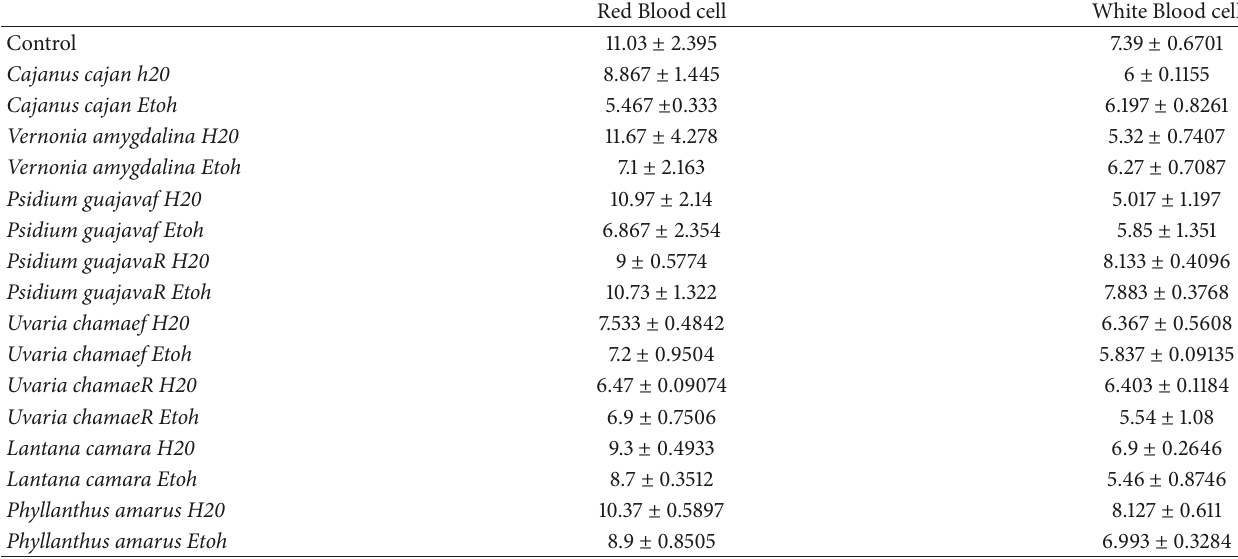
Table 3: Changes in the levels of white cells and red blood cells in the treated and control rats.